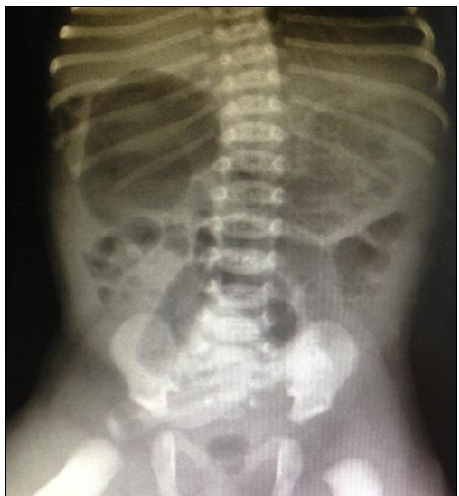
Figure 2: Neonatal flat plate, large gas bubble in RUQ suggestive of partial duodenal obstruction.